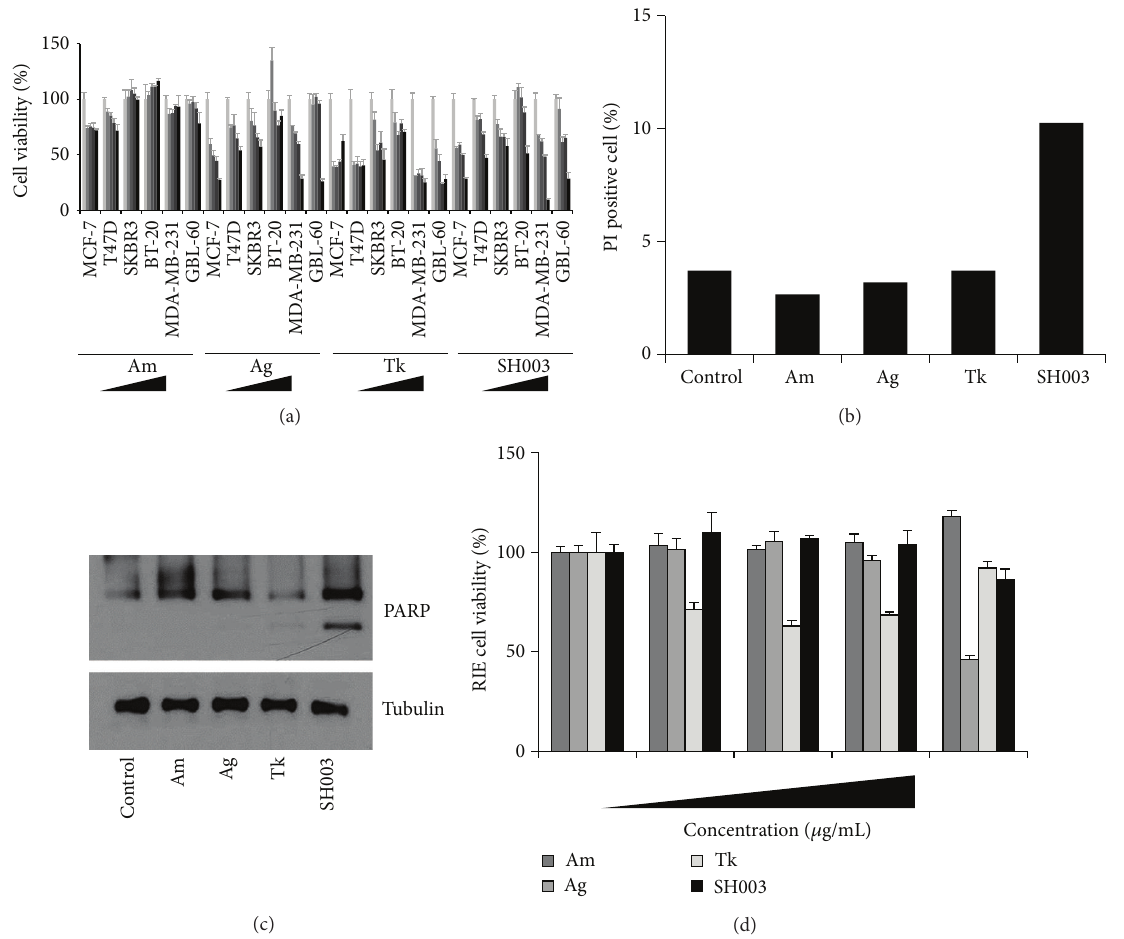
Figure 3: SH003 inhibits MDA-MB-231 growth and induces apoptosis. (a) Different breast cancer cells were seeded on 96-well plates and treated with each extract at different concentrations for 72 hours. Experiments were performed three times in sextuplicate. Representative data were presented as the means and standard deviations. Right triangles indicate the doses of each extract (0, 50, 100, 200, and 500 𝜇 g/mL), which was also marked with bars in different colors. (b) MDA-MB-231 cells were treated with 500 𝜇 g/mL of the each extract. Cells were stained with propidium iodide (PI, 50 𝜇 g/mL) at room temperature in the dark. PI-positive apoptotic cells were detected using FACSCalibur. ∗ 𝑃 < 0.05 . (c) MDA-MB-231 cells were treated with the indicatives at 500 𝜇 g/mL for 24 hours and then subjected to western blots. Tubulin was used for the intimal control. (d) RIE cells were seeded on 96-well plates and treated with each extract at different concentrations for 72 hours. Experiments were performed three times in sextuplicate. Representative data were presented as the means and standard